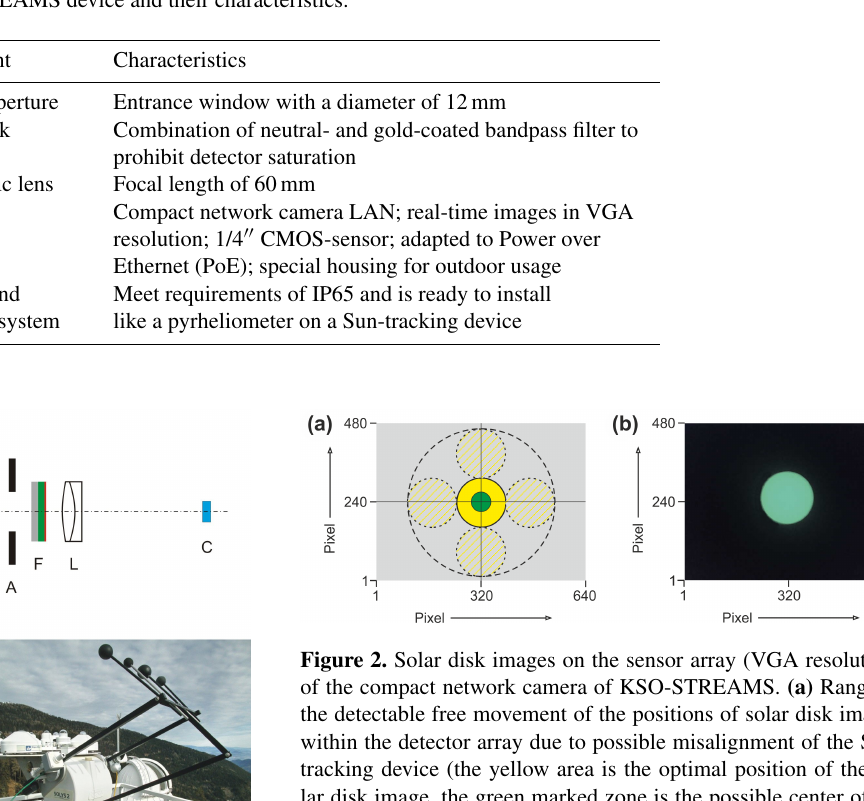
Table 1. Components of the KSO-STREAMS device and their characteristics.